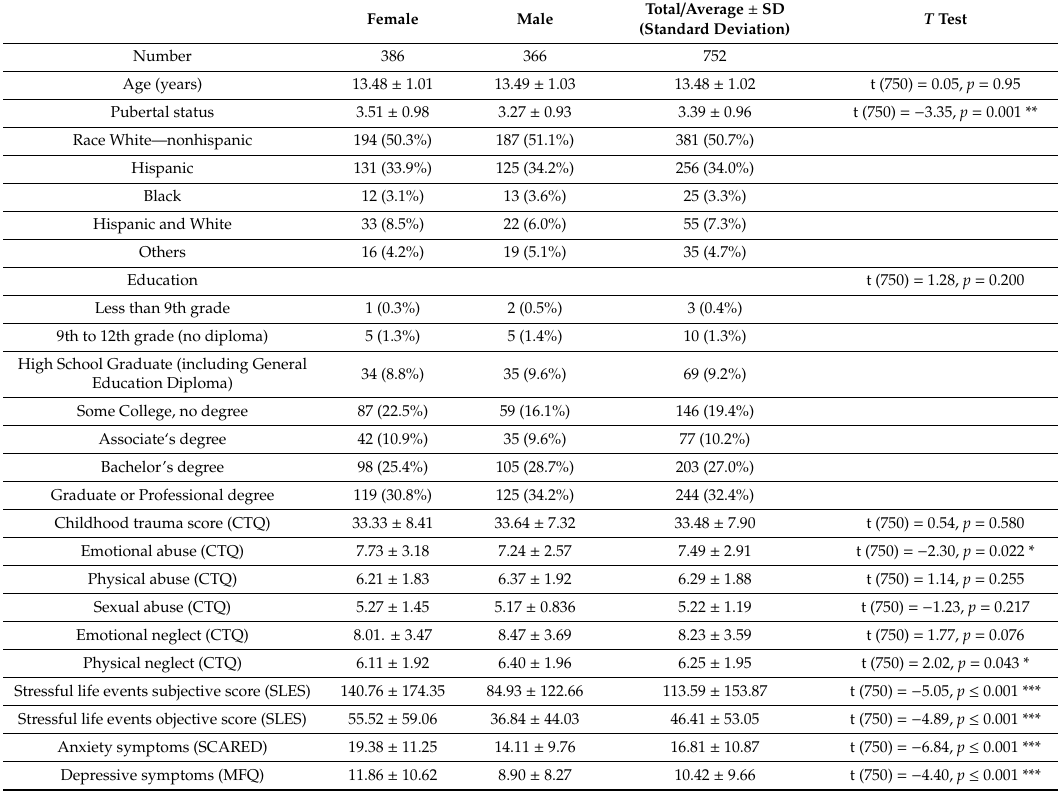
Table 1. Demographics of the